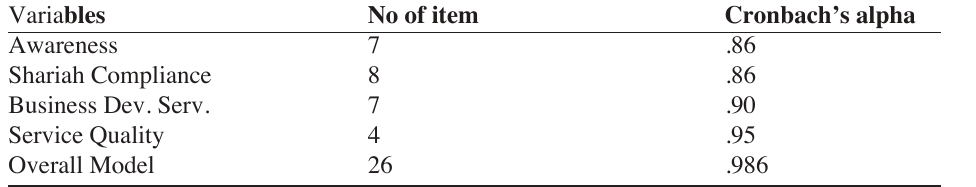
Table 3: Reliability Analysis: Cronbach’s Alpha Varia